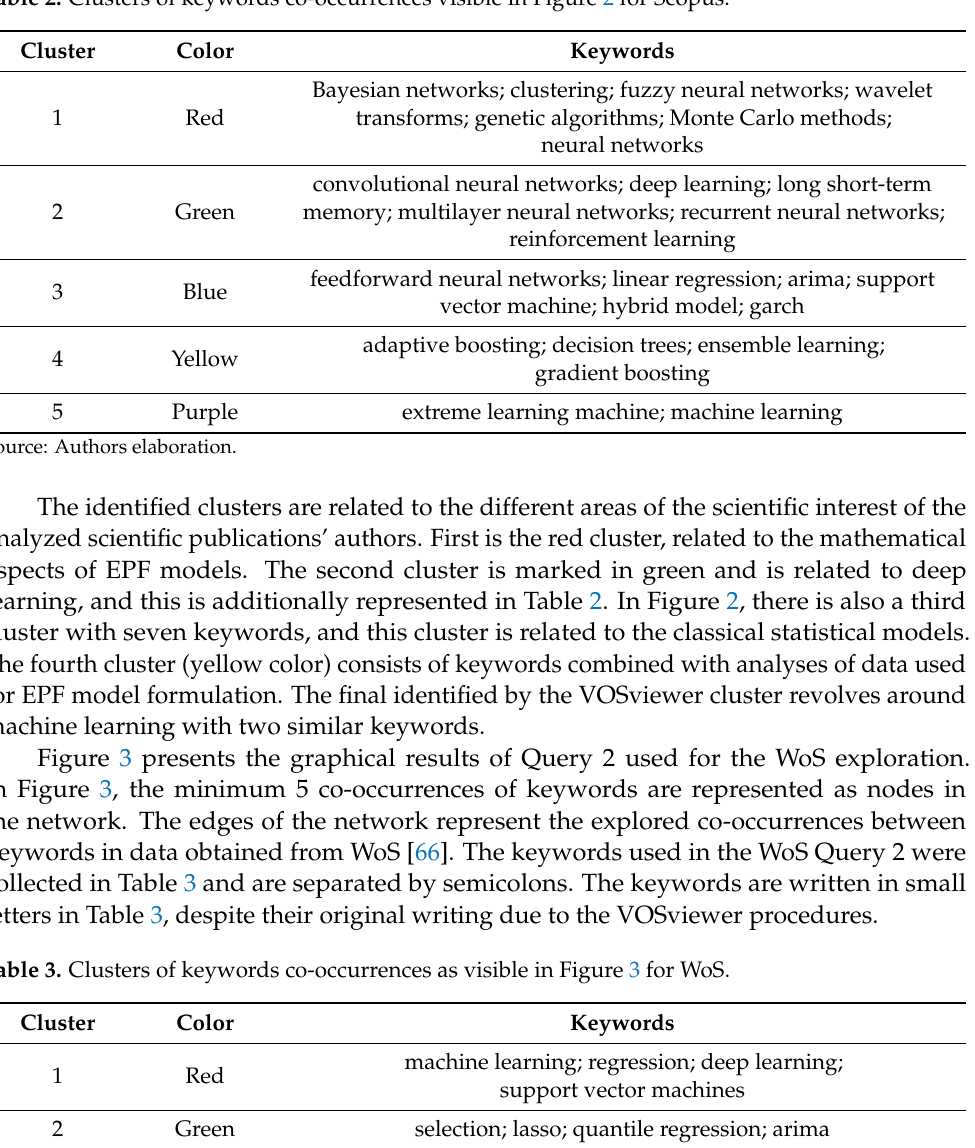
Table 2. Clusters of keywords co-occurrences visible in Figure 2 for Scopus.